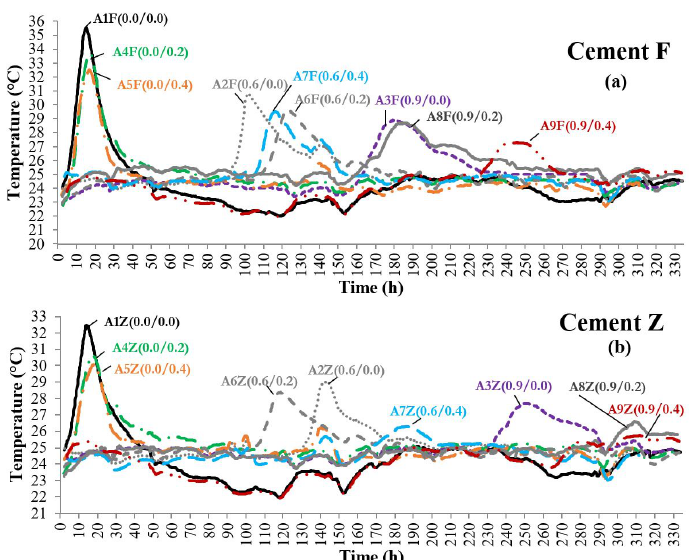
Figure 7. Evolution of the mortar temperatures over time, for cement F (a) and cement Z